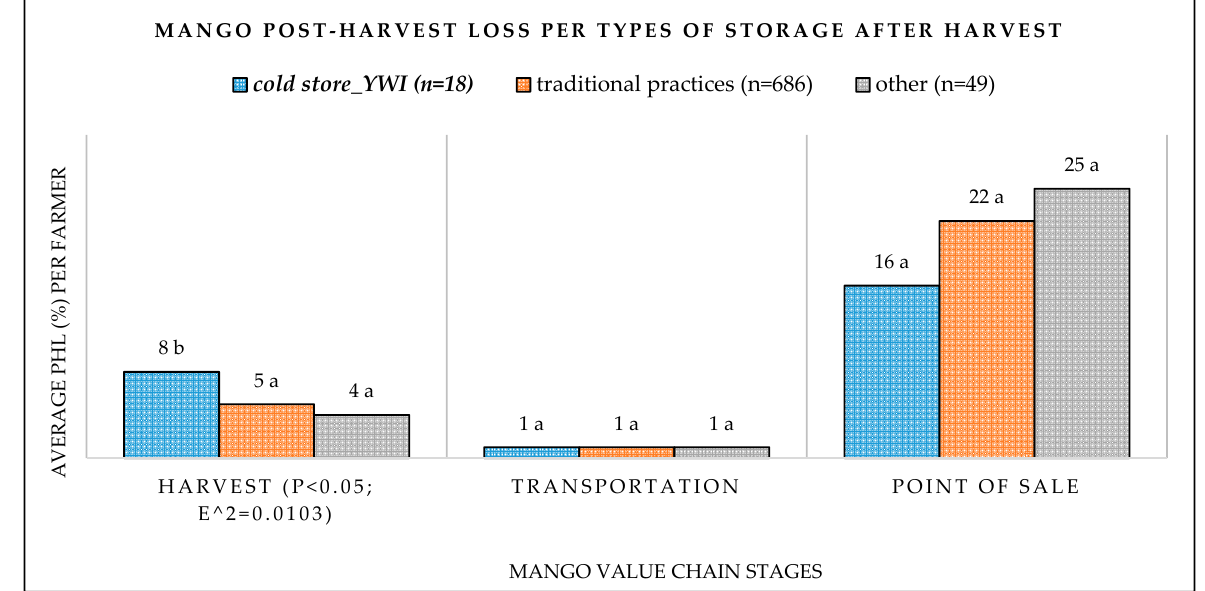
Figure 4. Comparing cold stores to alternative storage types after harvest. Values with different letters are significantly different at p < 0.05 from the Kruskal–Wallis analysis, Dunn test, and Benjamini–Hochberg adjustment. E^2 = Epsilon- squared value for effect size. YWI refers to the technology that the Yieldwise Initiative promoted. ( n ) refers to the number of farmers who reported using a given practice or technology. ‘Other’ refers to practices that combined both YWI promoted technologies and traditional practices.